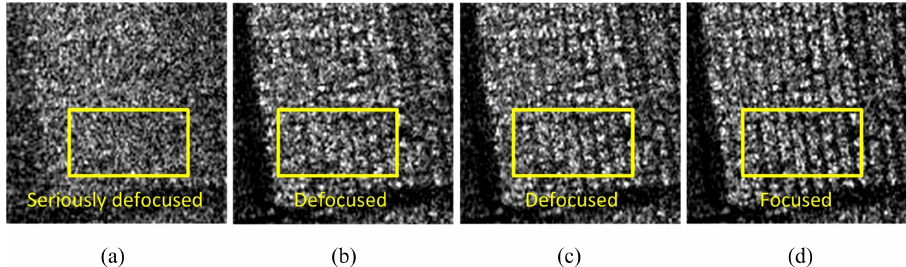
Figure 15. Magnified sub-scene images 1. ( a ) Processed with INS-only MOCO. ( b ) Processed with conventional MDA. ( c ) Processed with RDMDA. ( d ) Processed with 2D-SVMDA.